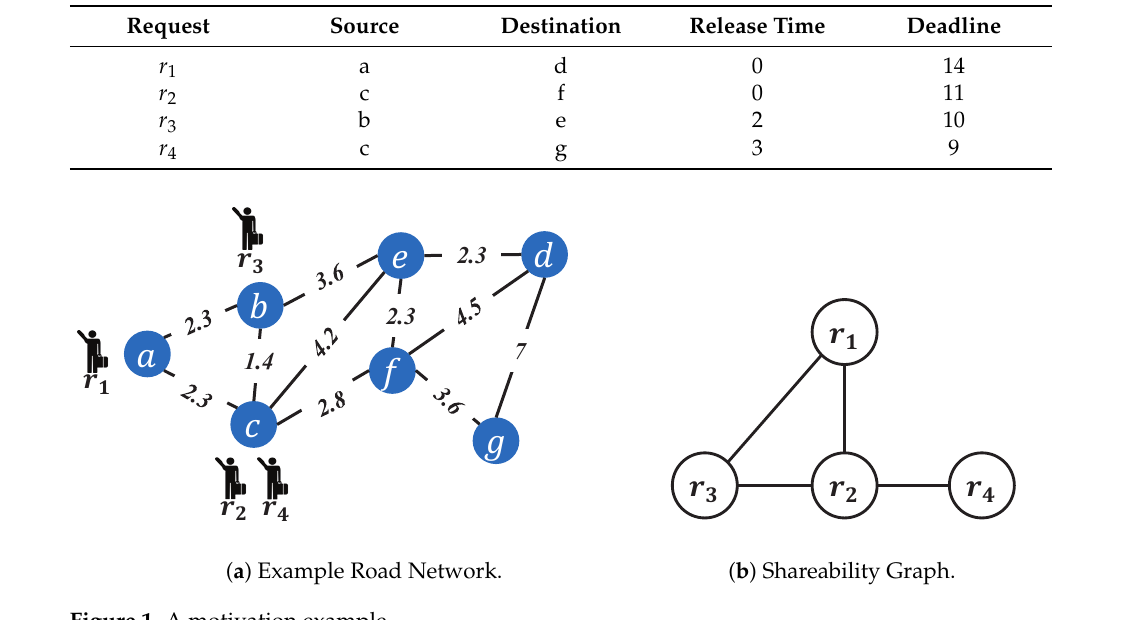
Figure 1. A motivation